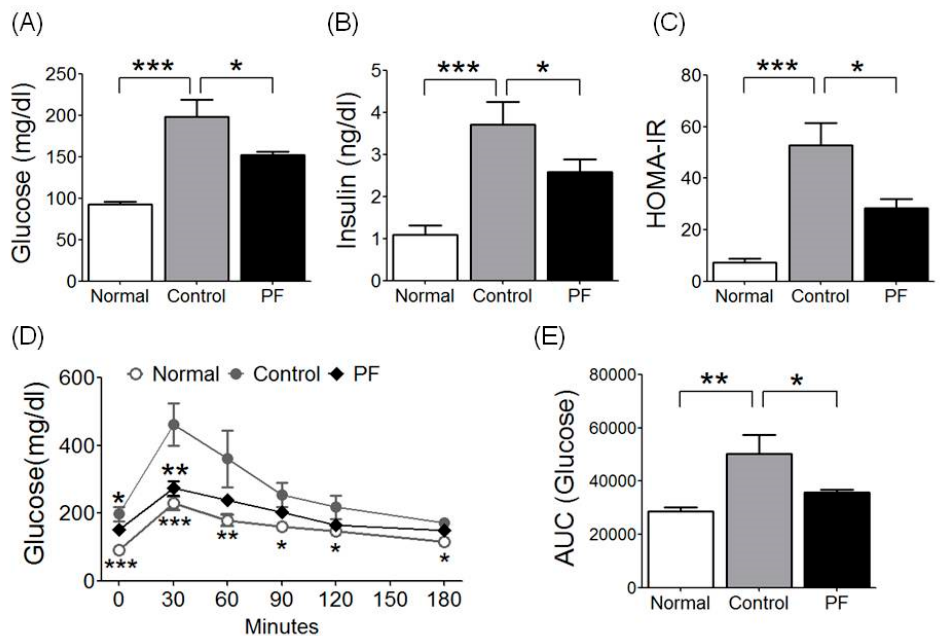
Figure 2. E ff ects of PF on ( A ) fasting glucose, ( B ) fasting insulin, ( C ) homeostatic model assessment for insulin resistance (HOMA-IR), and ( D , E ) oral glucose tolerance test (OGTT) and area under curve (AUC), respectively. n = 6 in each group. Data shown are the mean ± SEM. * p < 0.05, ** p < 0.01, *** p < 0.001, compared with